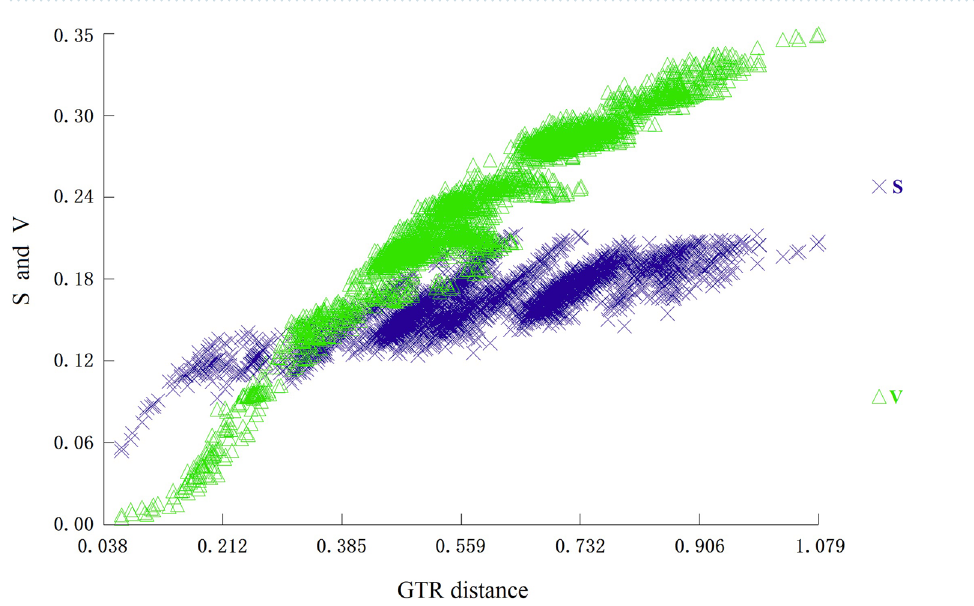
Figure 5. Saturation plots for 13 PCGs. The plots show the uncorrected pairwise divergence in transitions (s) and transversions (v) against the divergence calculated using the GTR